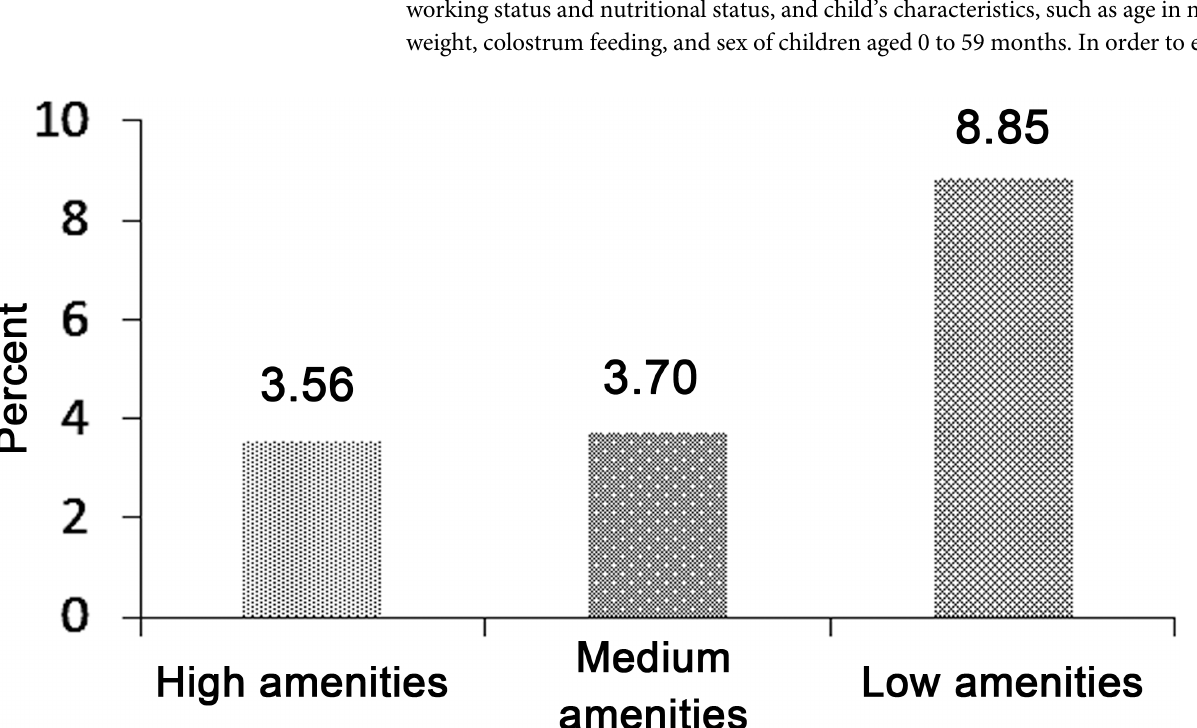
Fig 2. Prevalence of severe wasting of children 0 – 59 months by Macro Amenities Index (MAI) in Northeast India. Source: Based on authors computation from Census 2001 – 2011 and NFHS-3 (2005 – 06)